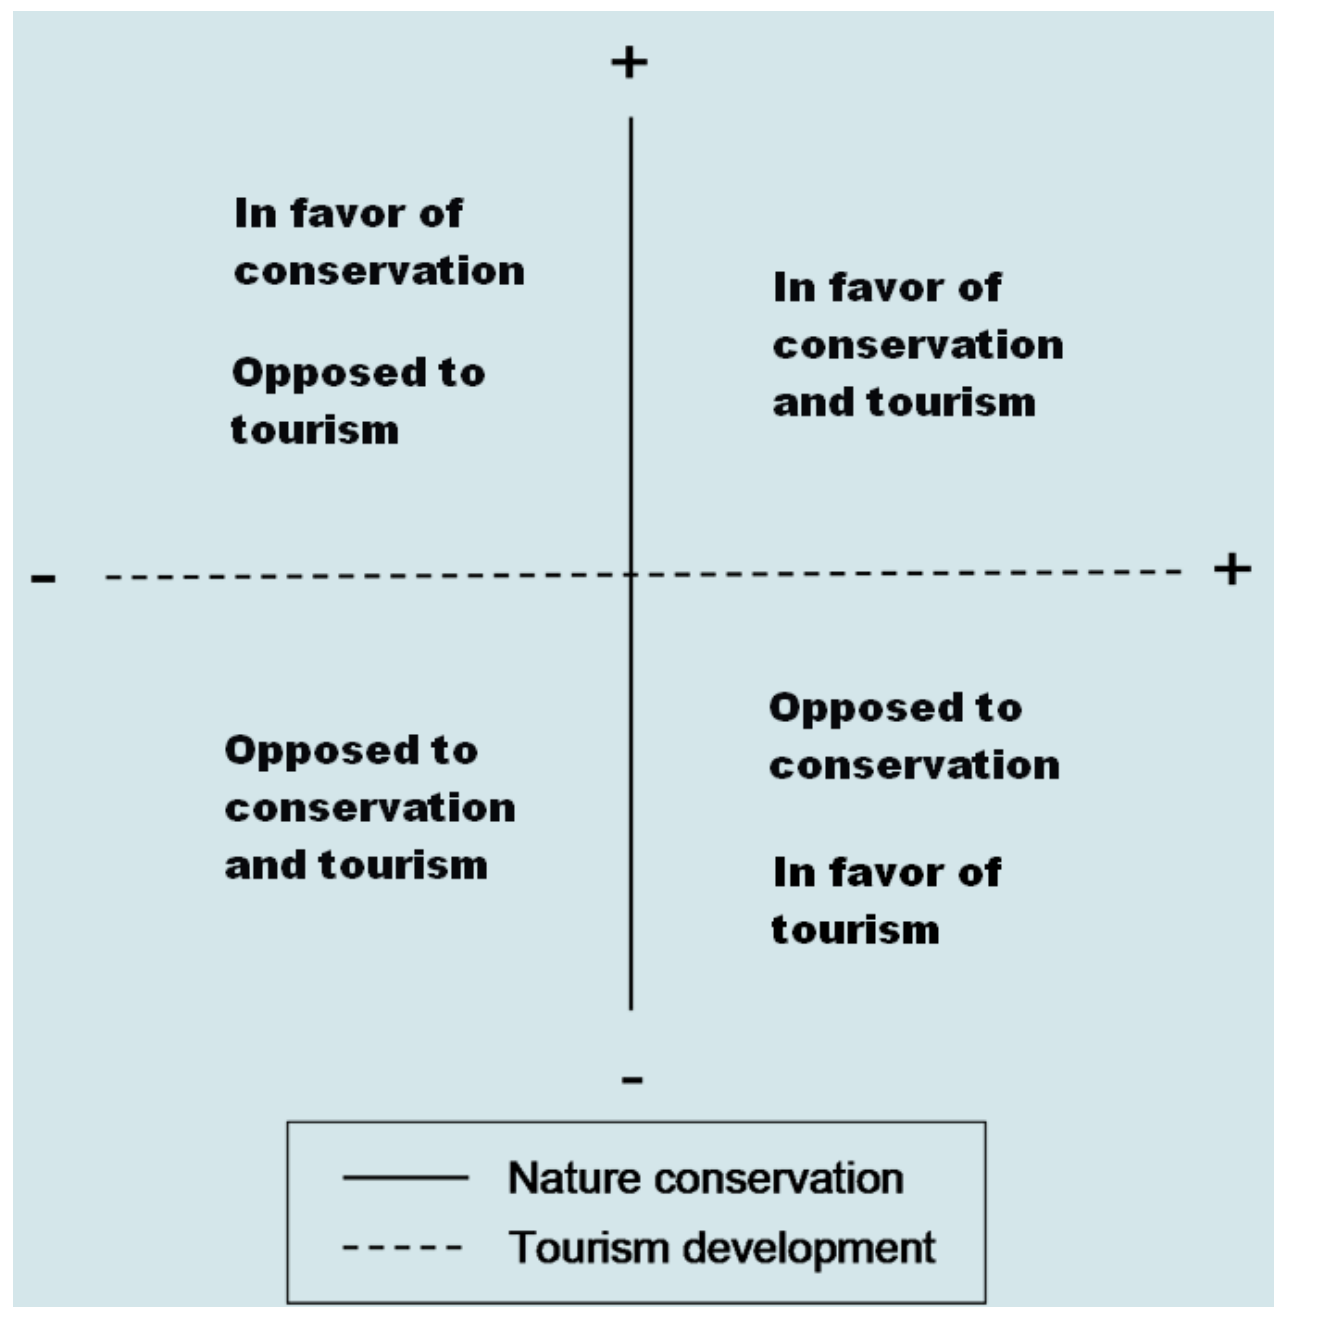
Fig. 1 . Schematic model of the opinions of residents about nature conservation and tourism